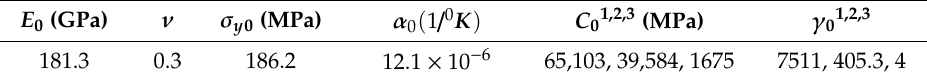
Table 1. Values of material properties CS 1026 used in numerical procedure [32,33].